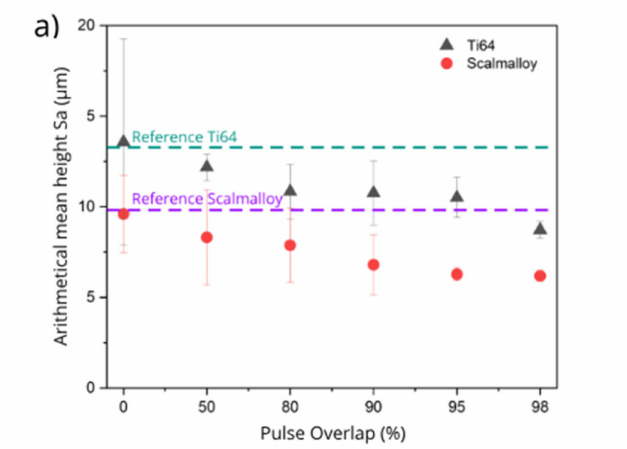
Figure A1. ( a ) Surface roughness Sa as a function of the pulse overlap for the DLIP treated titanium and aluminium alloys. The used laser fluence was 3.2 J/cm 2 for all